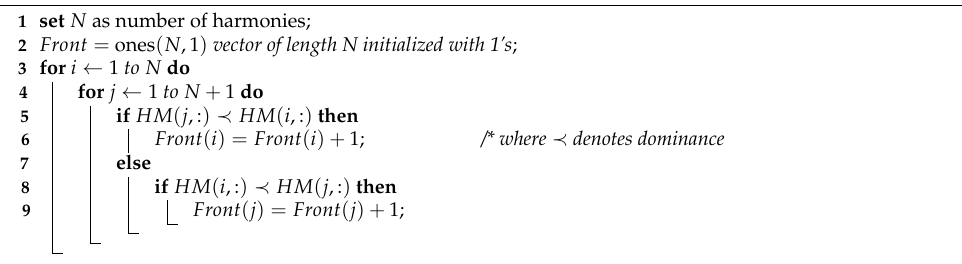
Algorithm 1 Non-dominated ranking of HM